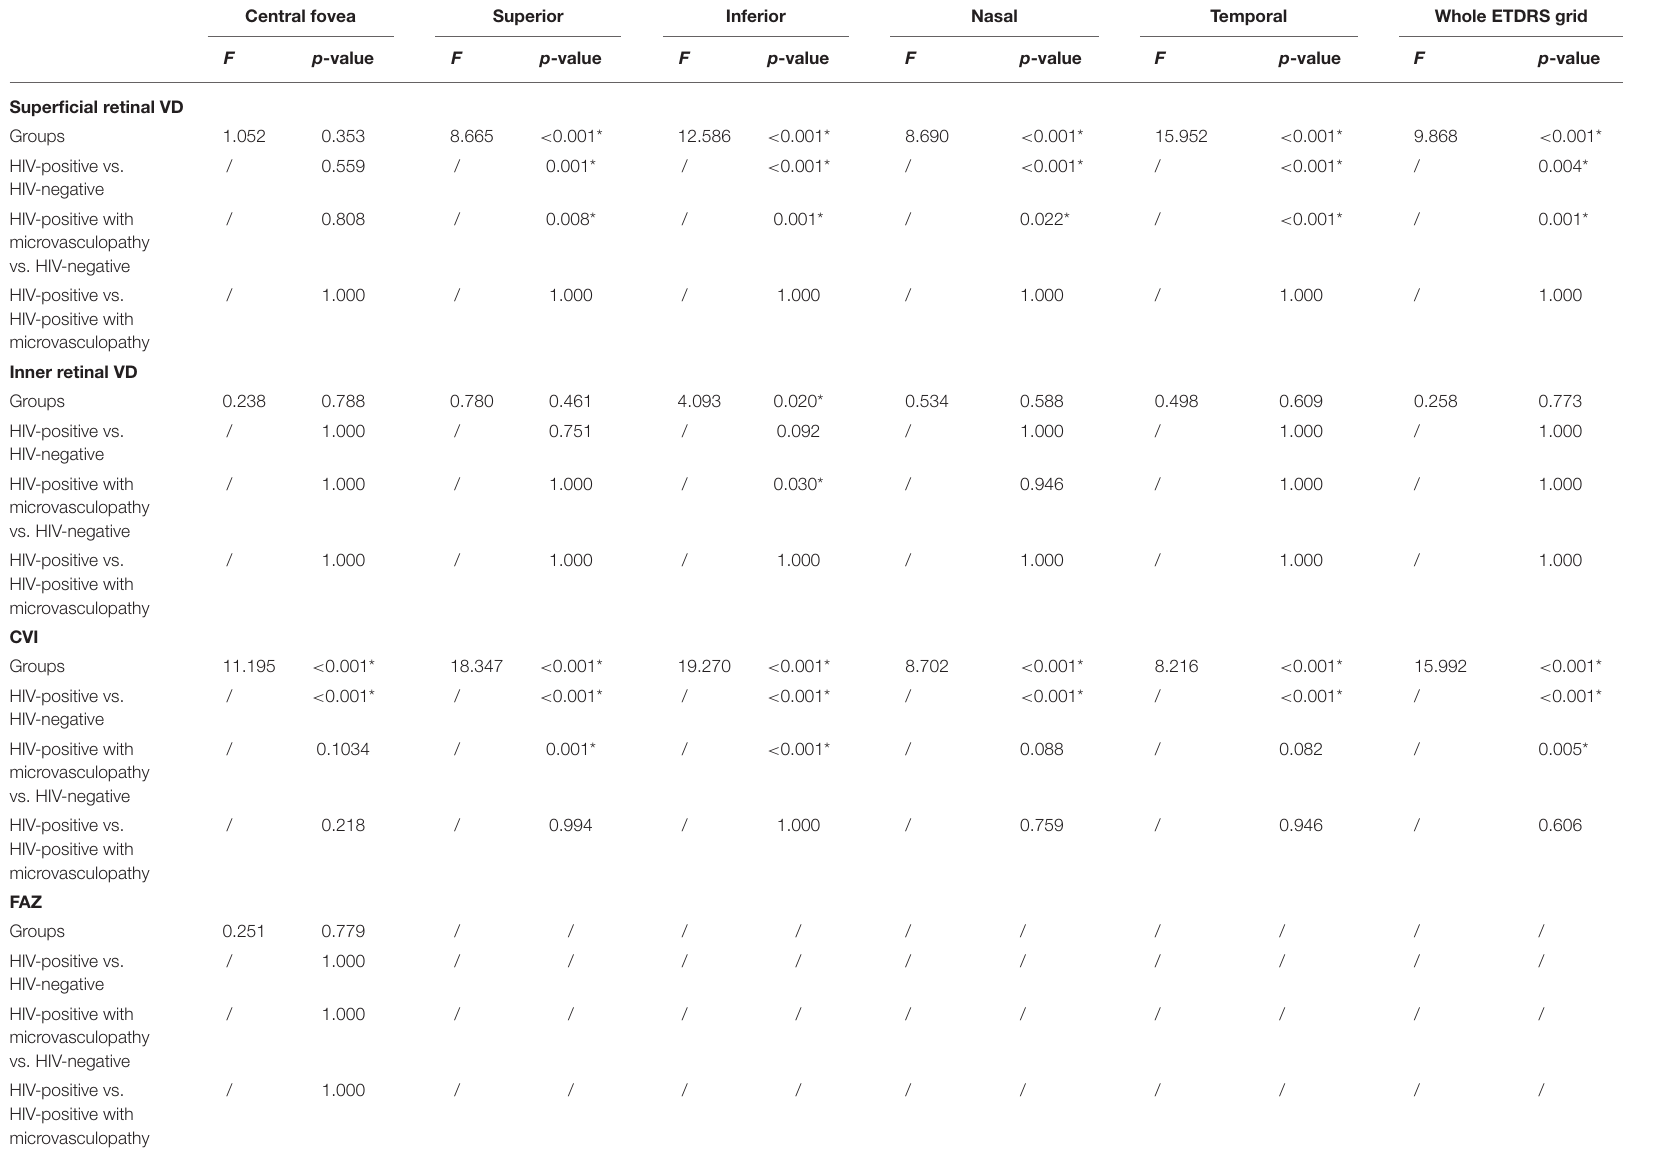
TABLE 2 | Statistical results of macular microvasculatural parameters between